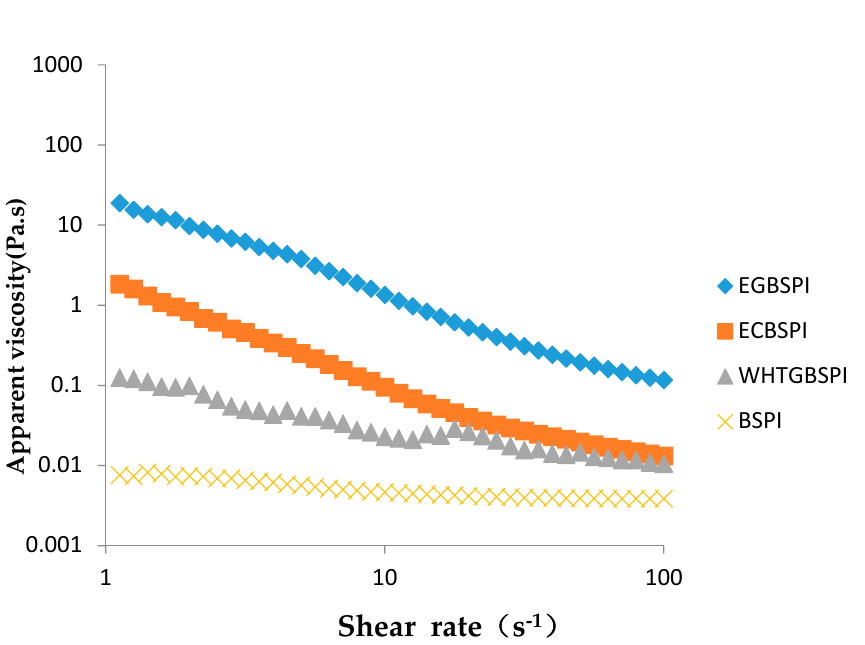
Figure 9. Rheological property of the suspensions prepared with BSPI and its modified products.